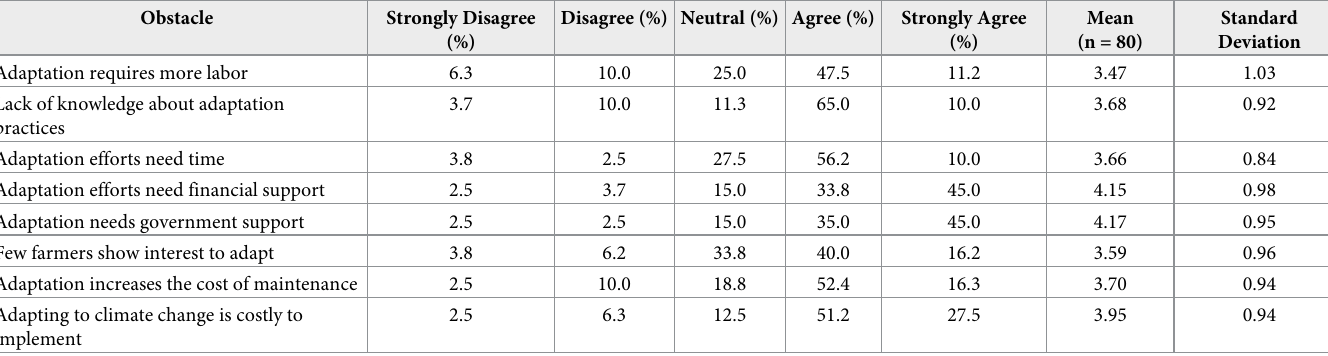
Table 5. Frequency distribution of the farmers’ view of obstacles to adaptation.